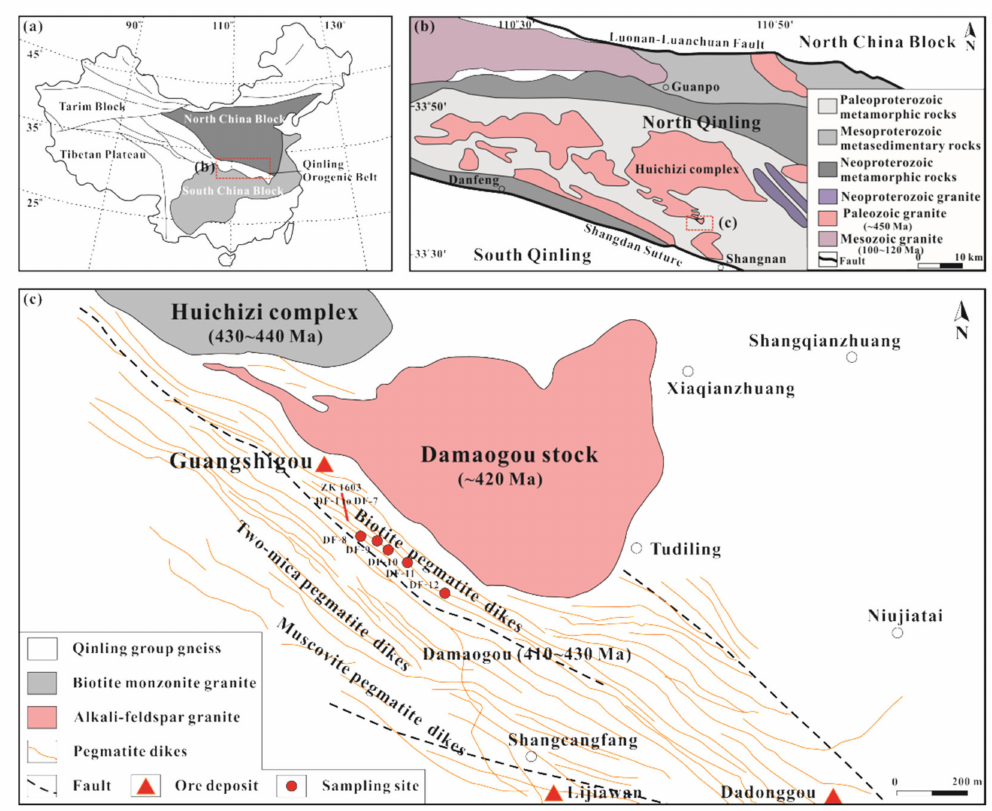
Figure 1. ( a , b ) Simplified geotectonic map showing the location and major units of the North Qinling Orogenic Belt (modified after Wang et al. [32]) and ( c ) schematic geological map of the Guangshigou uranium deposit (modified after Zuo et al.